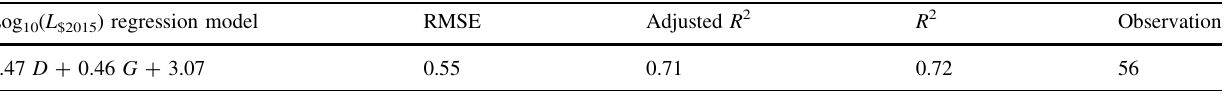
Table 8 Regression of the economic loss adjusted to 2015 USD value ( L $2015 ) considering GDP.Unit and damage ( D 4 ? D 5) as the exposure- related and hazard-related variables, respectively, and all of the earthquakes having these information (56 from Tables 1, 2) Log 10 ( L $2015 ) regression